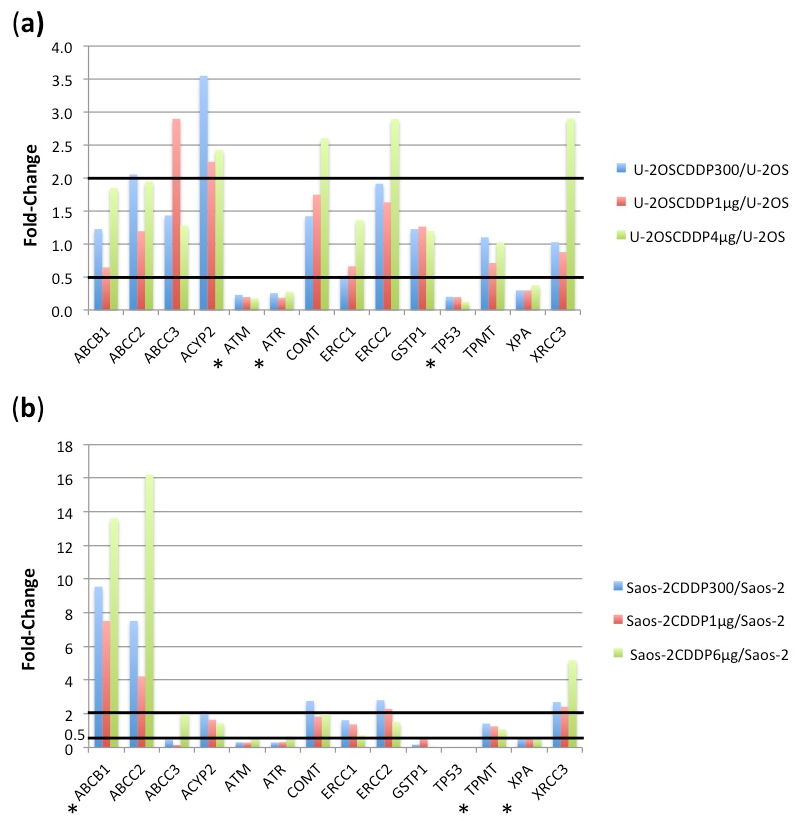
Figure 7. Fold ‐ changes of RNA expression in U ‐ 2OS cisplatin (CDDP) ‐ resistant variants ( a ) and Saos ‐ 2 CDDP ‐ resistant variants ( b ) compared to their parental cell lines. Thick lines indicate thresholds for overexpression (2 ‐ fold) and under ‐ expression (0.5 ‐ fold). * indicates those genes that were significantly differentially expressed in the groups of U ‐ 2OS and Saos ‐ 2 CDDP ‐ resistant variants compared to their respective parental cell line.